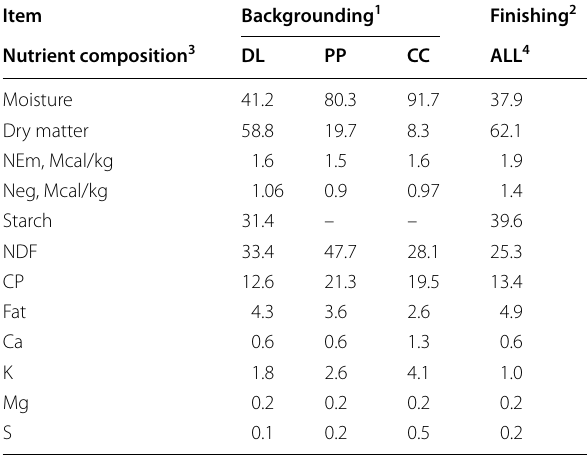
Table 1 Nutrient composition of backgrounding diet (% of DM) fed to